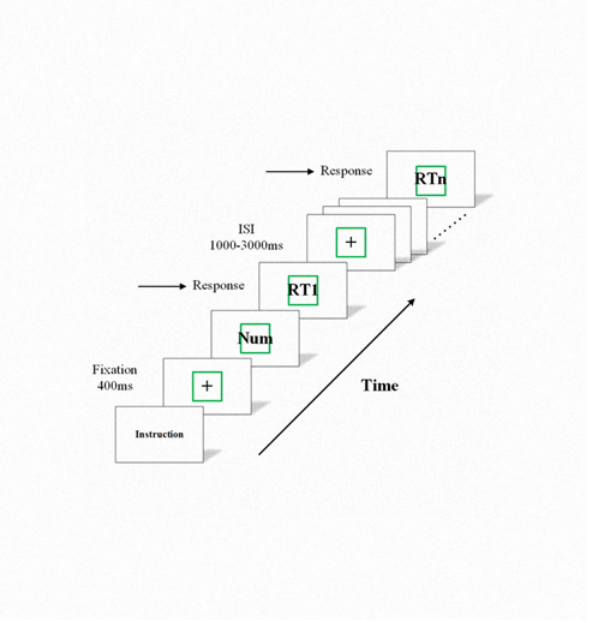
Fig 1. PVT procedures. A fixation point was first presented for 400 ms. Then, each Arabic numeral was presented for 1,000 ms. Participants were asked to press the space key as soon as possible. The ISI was 1,000 ms to 3,000 ms.